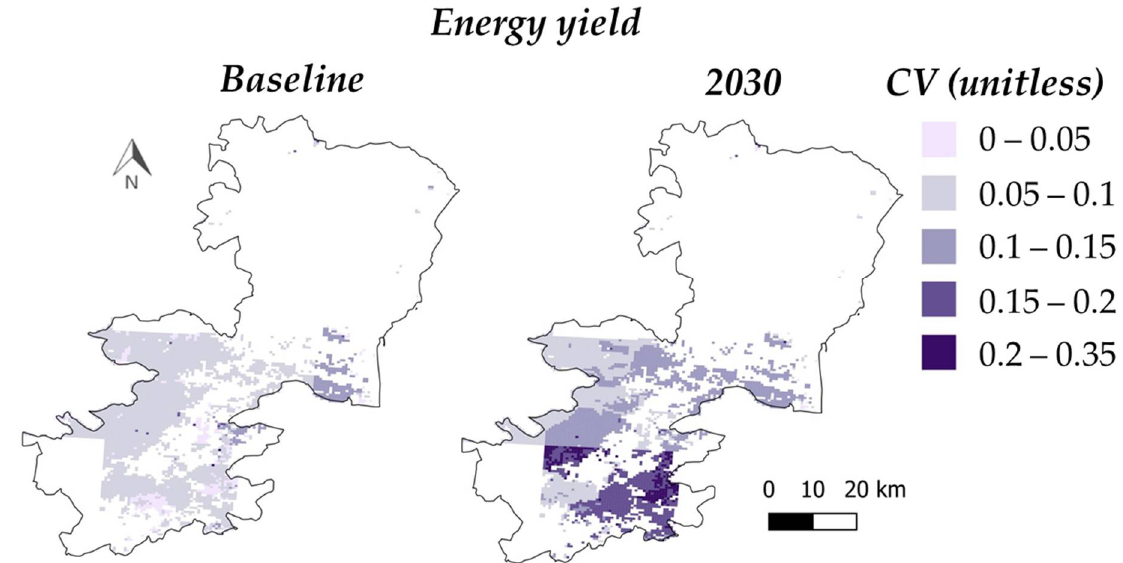
Figure 8. Variability of energy yield simulated across the marginal areas of the Catania province under current and future climate scenarios. The results are presented, for each simulation unit, as coefficient of variation (CV; unitless) computed for the whole 30-year period centered on 2000 (baseline) and 2030 (future climate).